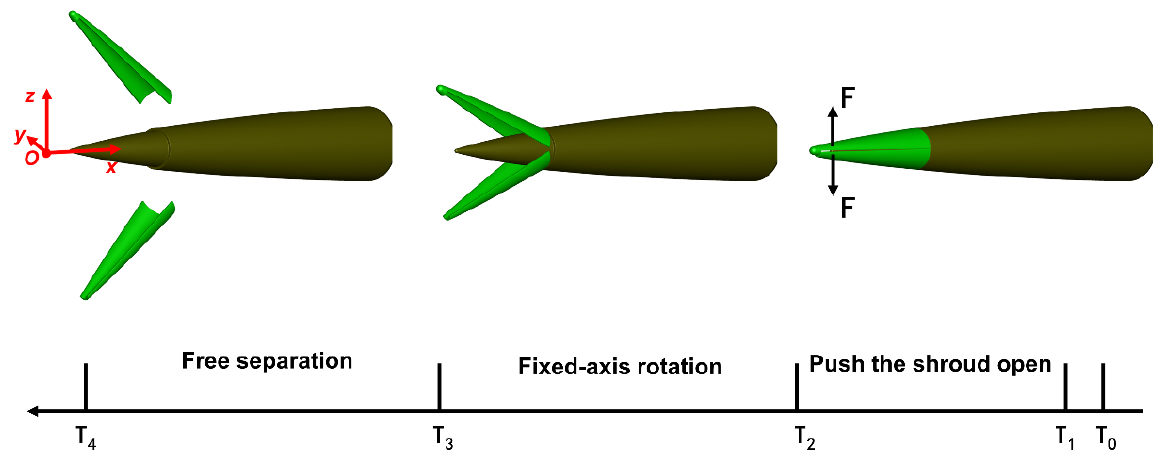
Figure 4. Schematic diagram of the shroud separation process.